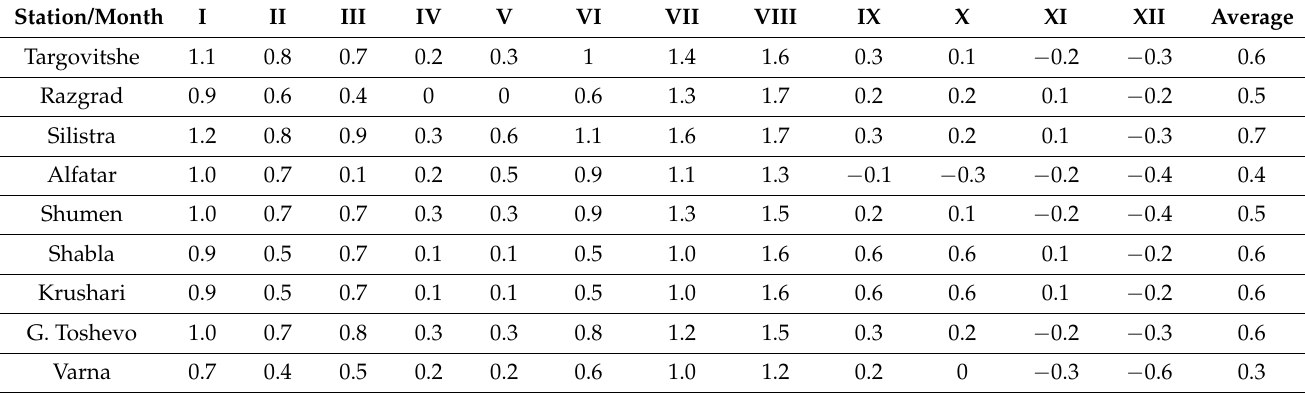
Table 4. Average monthly temperatures deviations in northeastern Bulgaria in the period